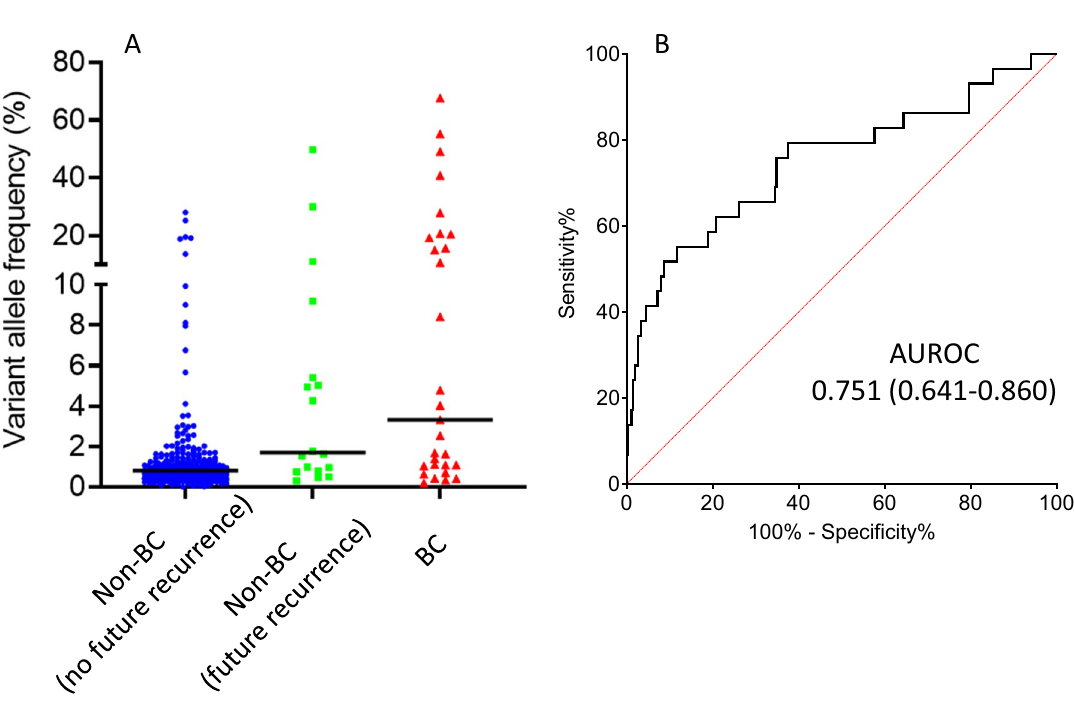
Figure 4. Hotspot mutations in urine cpDNAs from NMIBC surveillance patients. ( A ) Shows VAFs in surveillance clinic cpDNAs. Horizontal bars represent median values. ( B ) Shows the ROC curve for recurrent BC detection obtained by varying the VAF used for variant